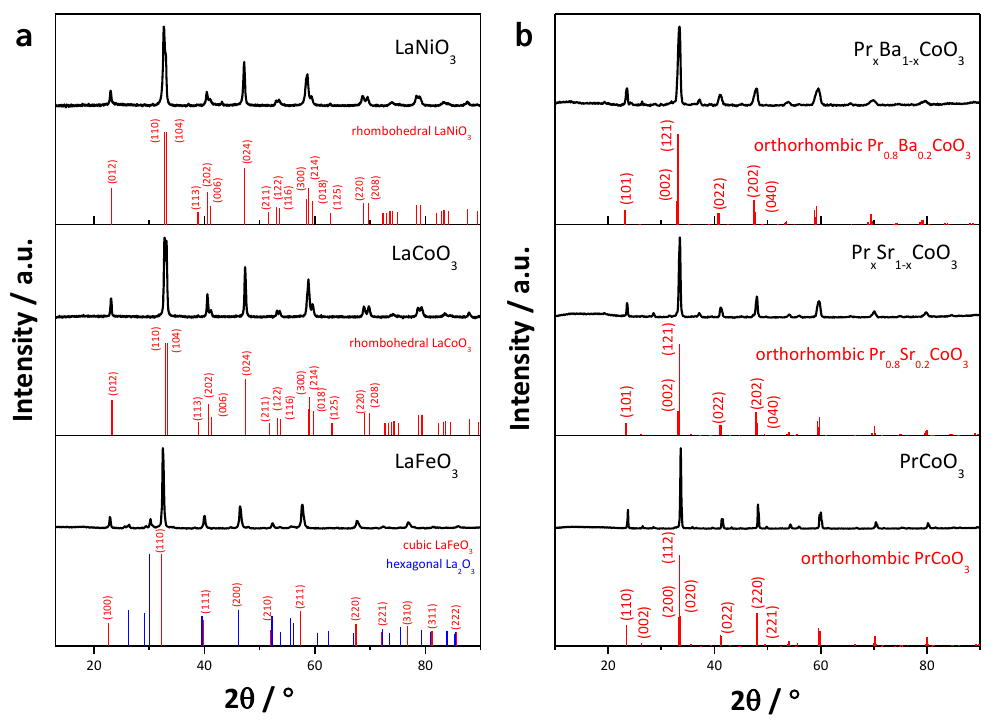
Figure 1. Powder XRD patterns of ( a ) LaFeO 3 , LaCoO 3 , LaNiO 3 ; ( b ) PrCoO 3 , Pr x Sr 1-x CoO 3